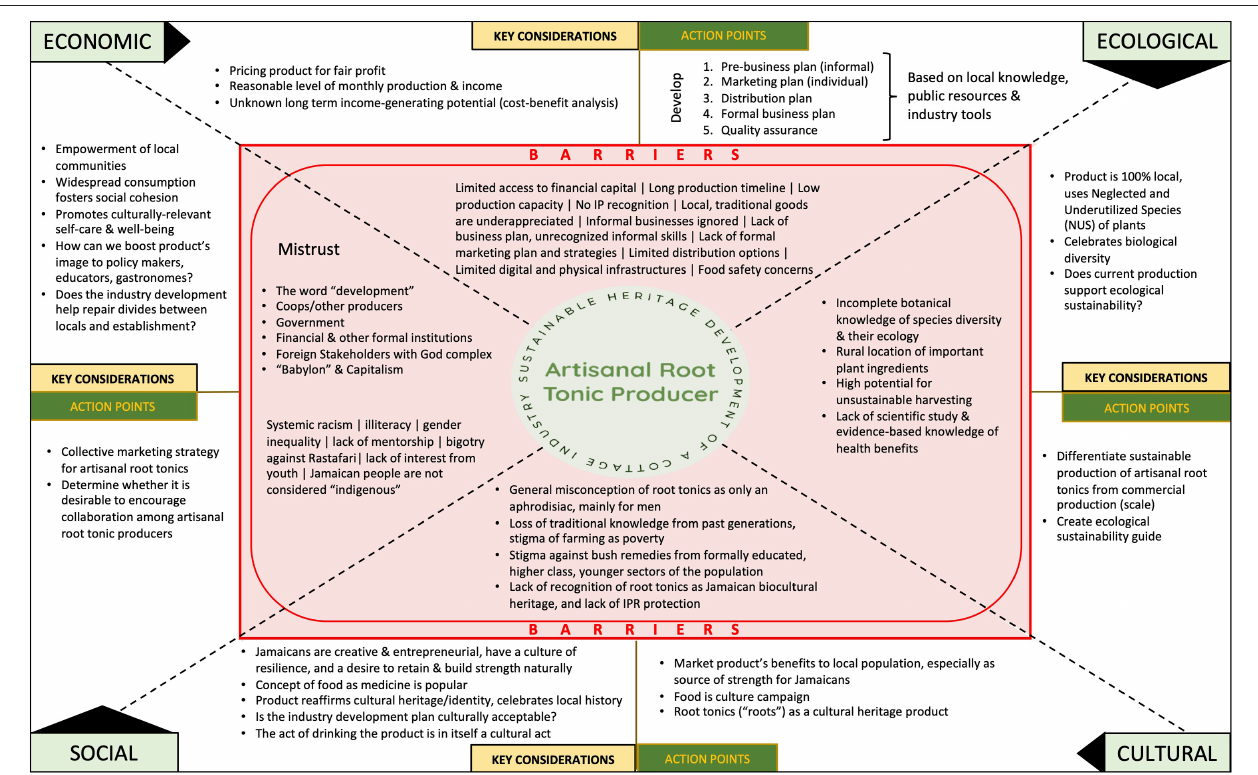
FIGURE 6 | Identification of key elements for the creation of a road map for sustainable development of root tonics (road map shown in Figure 7 ), based on four pillars (economic, ecological, cultural, and social). The arrows and diagonal dotted lines indicate and delineate the barriers, key considerations, and action points that are associated with each pillar. For example, for the ecological pillar, one of the barriers is that knowledge about the plant species used in root tonics (botanical identity and plant diversity) is incomplete, whereas a key consideration is that the production of root tonics is based on the use of local, Neglected and Underutilized Species (NUS) of plants; an action point for the development of a road map is to distinguish between sustainable production at a smaller, cottage industry scale, compared to a larger and more ecologically impactful industrial production line.